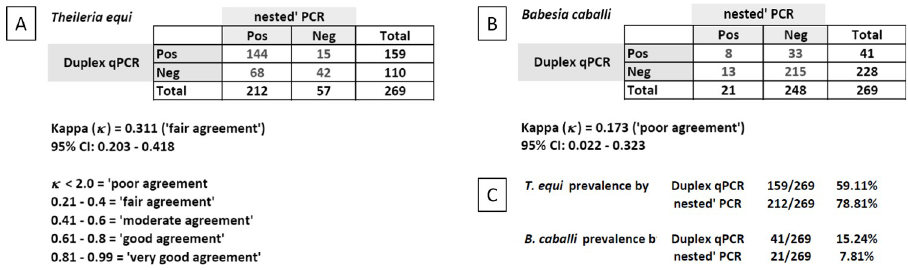
Fig 7. Kappa statistic calculations for the test results generated by the molecular assays used in this study. A) 2 × 2 contingency table for T . equi . B) 2 × 2 contingency table for B . caballi . C) Infection prevalences calculated using the nPCR and duplex qPCR test